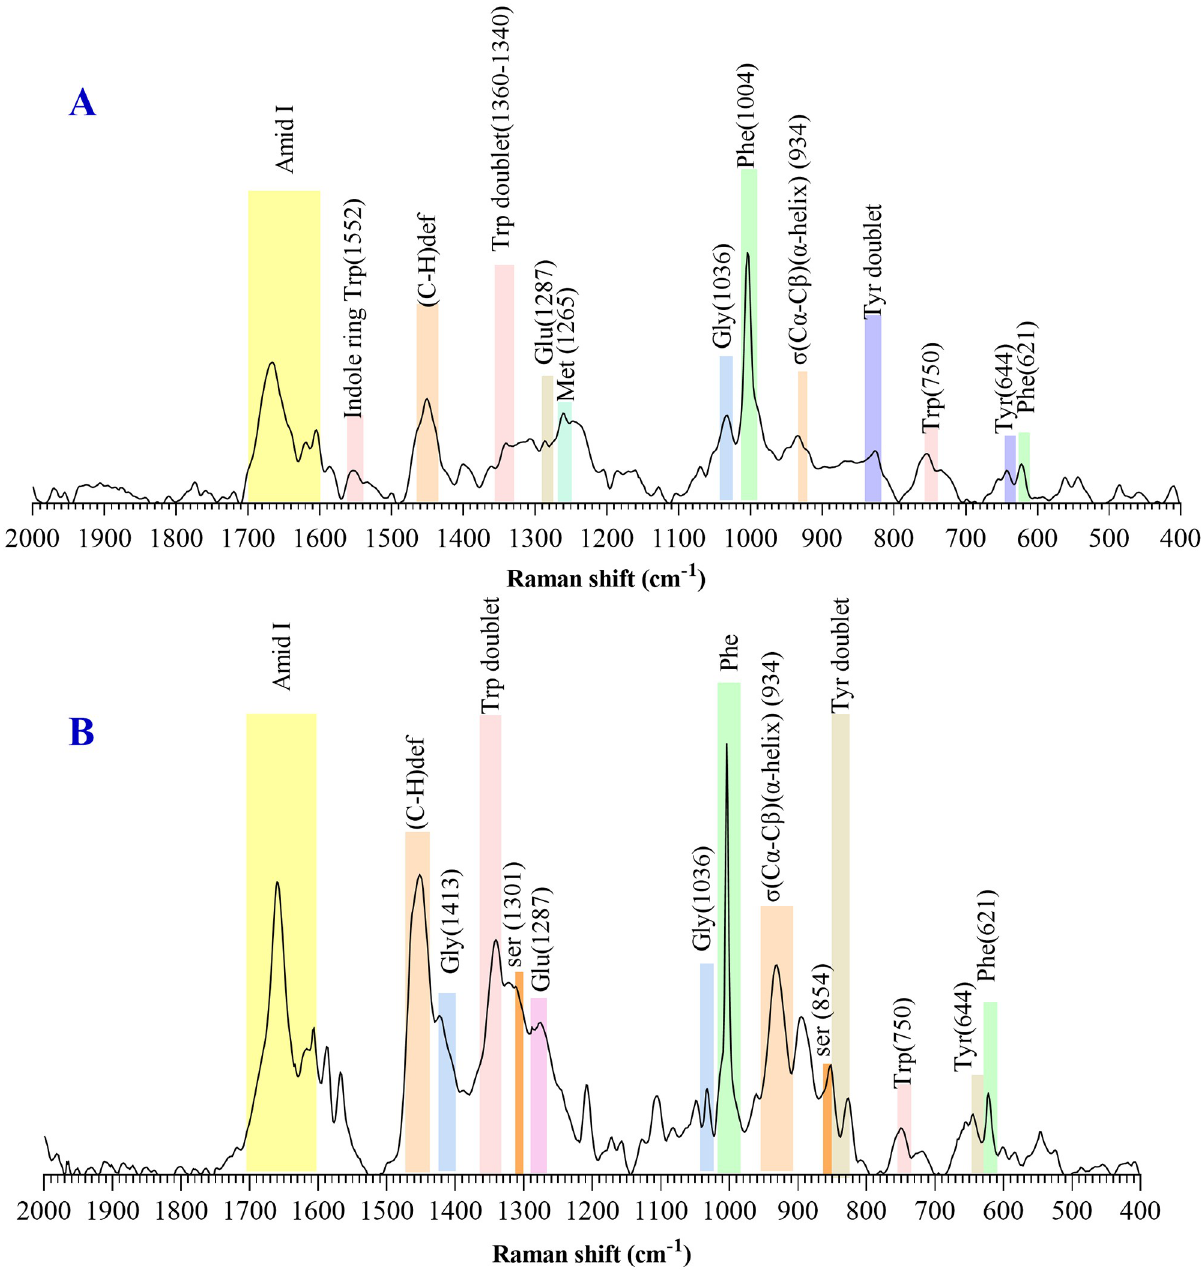
Fig 4. Raman spectral analyses of the α B-lir hybrid protein and LPP in the fingerprint region. The structure of α B-lir and LPP was characterized by Raman spectroscopy in the fingerprint region. Raman spectra of the LPP ( A ) and α B-lir hybrid protein ( B ) were indicated. different temperatures (Fig 6A). At 27˚C, the average oligomeric size of human α B-Cry was 15.8 ± 2.1, while at this temperature α B-lir oligomer indicates a diameter of 26 ± 2.6. With increasing temperature to 47˚C, the mean oligomeric size of the carrier protein was increased to 18.1 ± 3.4, but the observed diameter for the hybrid protein was significantly higher (993 ± 68.9). The α B-lir indicated a higher ability to form larger oligomers in all temperatures